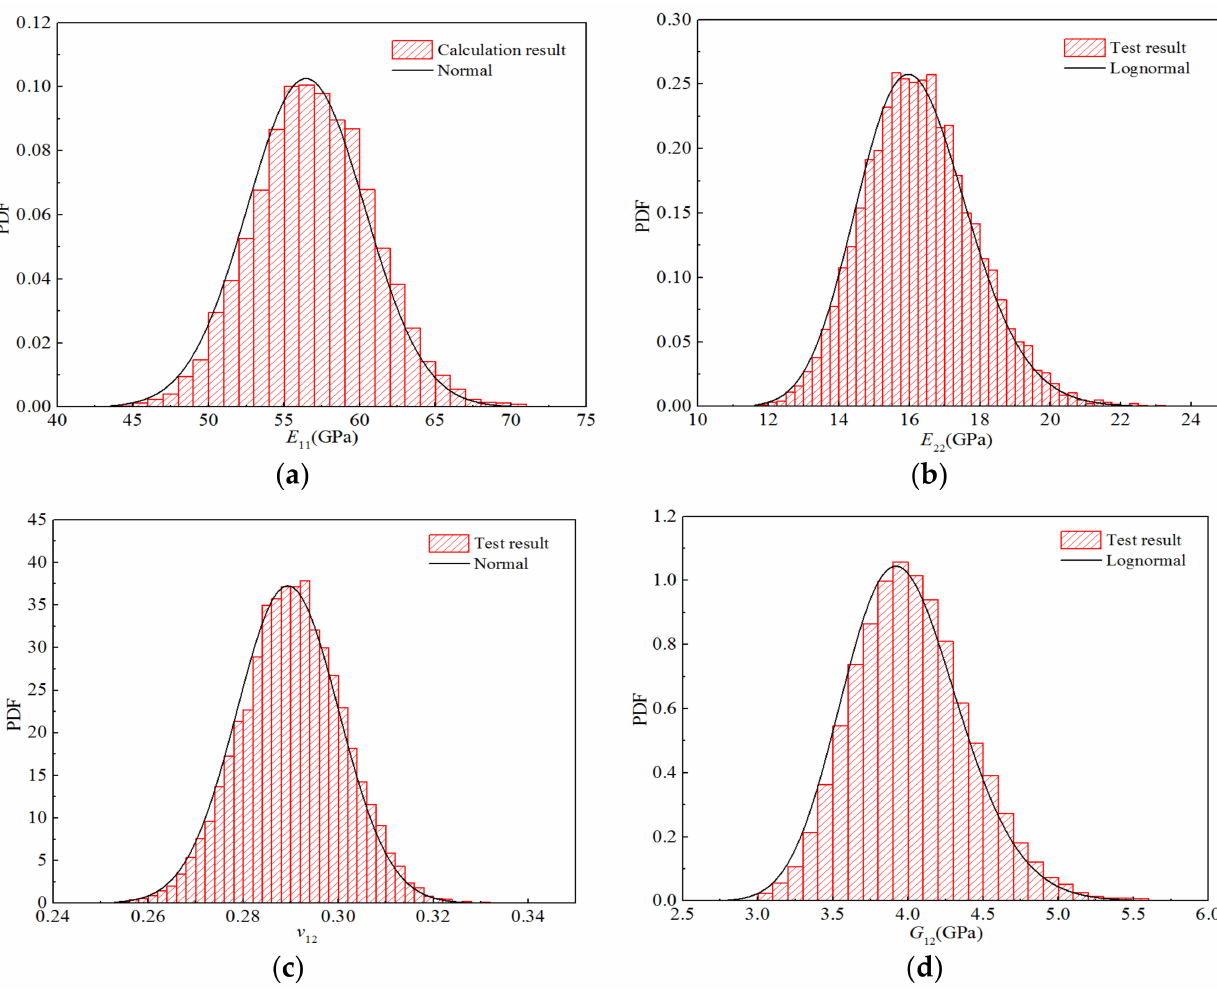
Figure 18. Probability distribution diagrams for the stiffness properties of H-GFRPs under RTD conditions. ( a ) E 11 , ( b ) E 22, ( c ) v 12 , ( d ) G 12